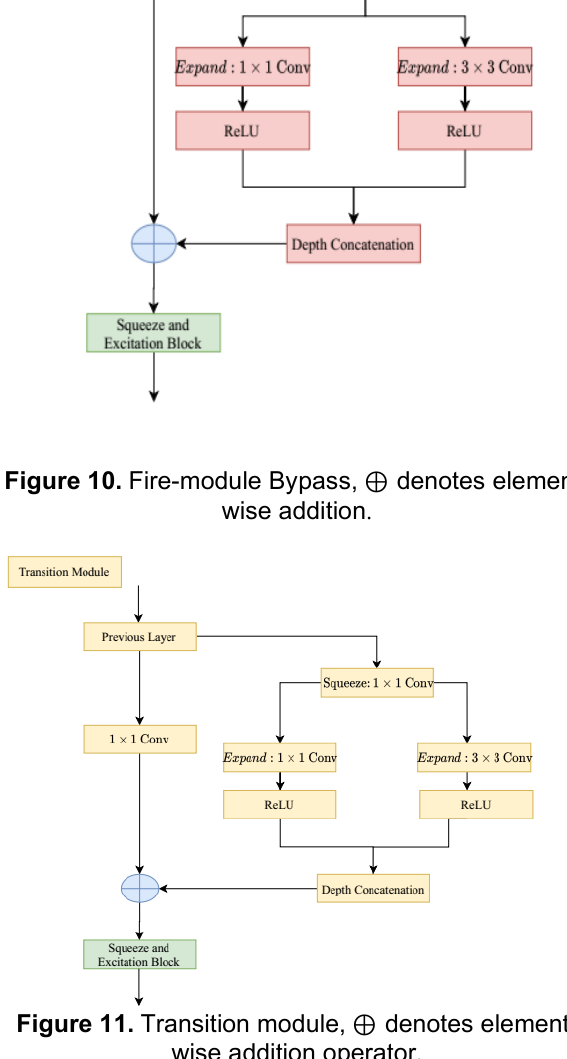
denotes element- Figure 11. Transition module, wise addition operator . ⊕